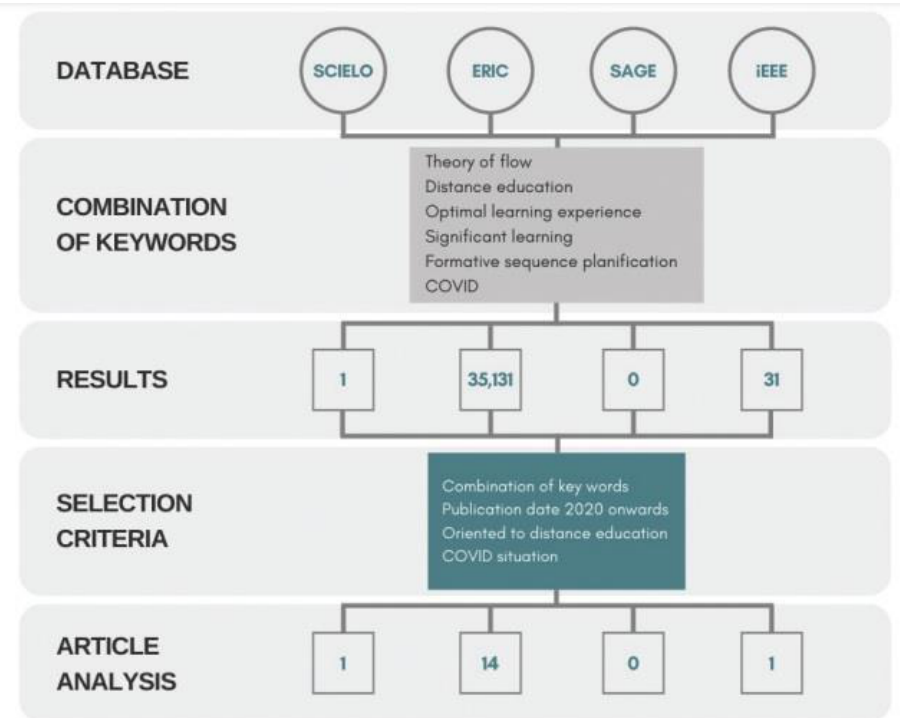
Figure A1. From a systematic literature review based on the educational databases SCIELO, ERIC, SAGE, and IEEE, we obtained a reduced set of 16 articles published since 2020, which report studies related to distance education, significant learning, and flow states in various school systems. Table A1. Synthesis of the information collected in the SLR and the possible links with the present investigation. Category Flow [26,38]